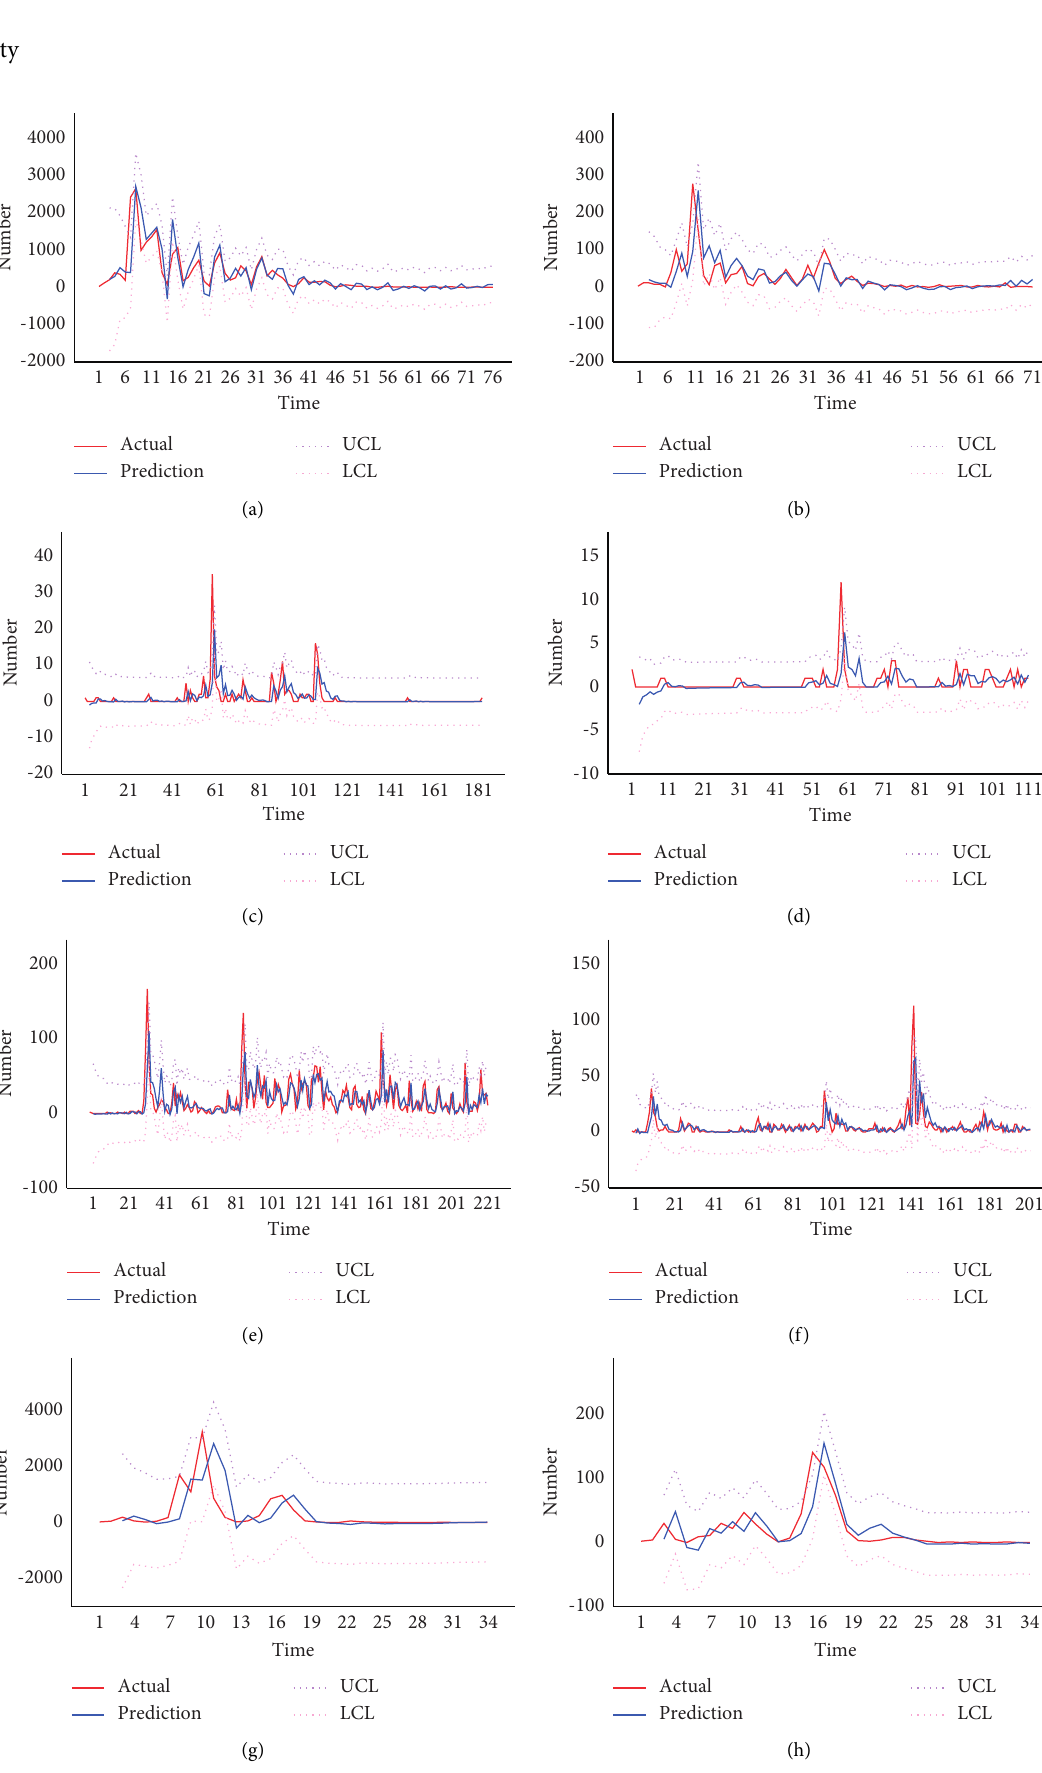
Figure 6: Actual and predicted values of ARIMA model in negative sentiment. (a) Natural disaster 1. (b) Natural disaster 2. (c) Accident 1. (d) Accident 2. (e) Public health 1. (f) Public health 2. (g) Social security 1. (h) Social security